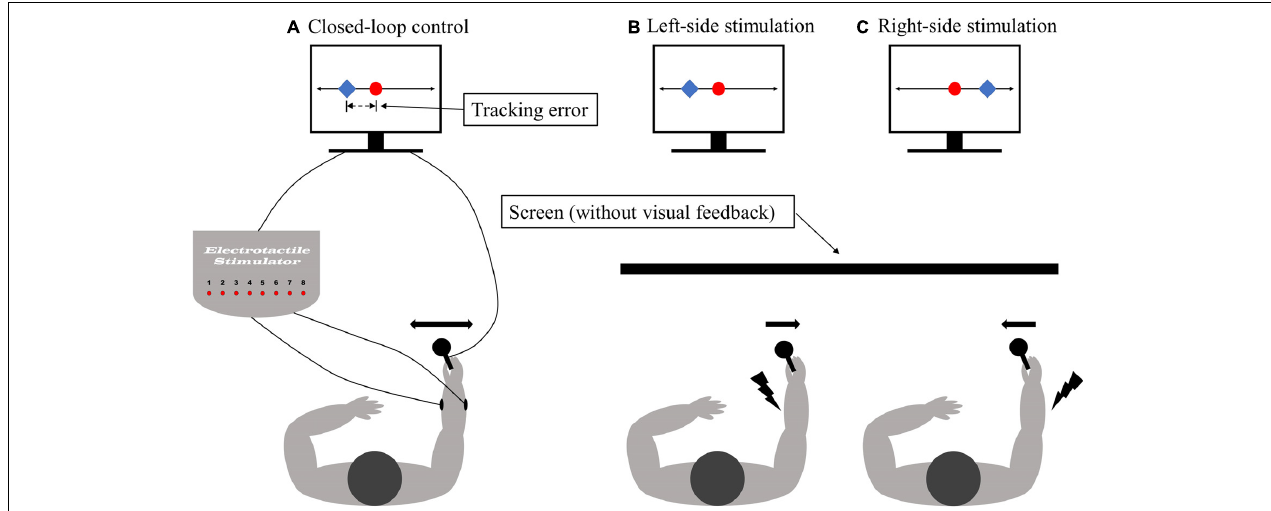
FIGURE 1 | The illustration of the experimental setup. (A) The closed-loop control system for compensatory tracking using electrotactile feedback. The feedback was delivered via surface and subdermal electrodes placed on the dorsal and volar side of the forearm (B,C) . The task for the subject was to track a reference trajectory based on the feedback of the momentary tracking error. When using visual feedback, the tracking error was represented as the difference in position between the controlled cursor (blue square) and the stationary reference (red dot). For tactile feedback, the stimulation was presented to the ventral (dorsal) forearm when the controlled cursor moved to the left (right) of the reference position (red dot). In response, the subject moved the joystick to the right (left) to bring the cursor back to the reference. The subjects were blinded (without visual feedback) during the experiment trails.